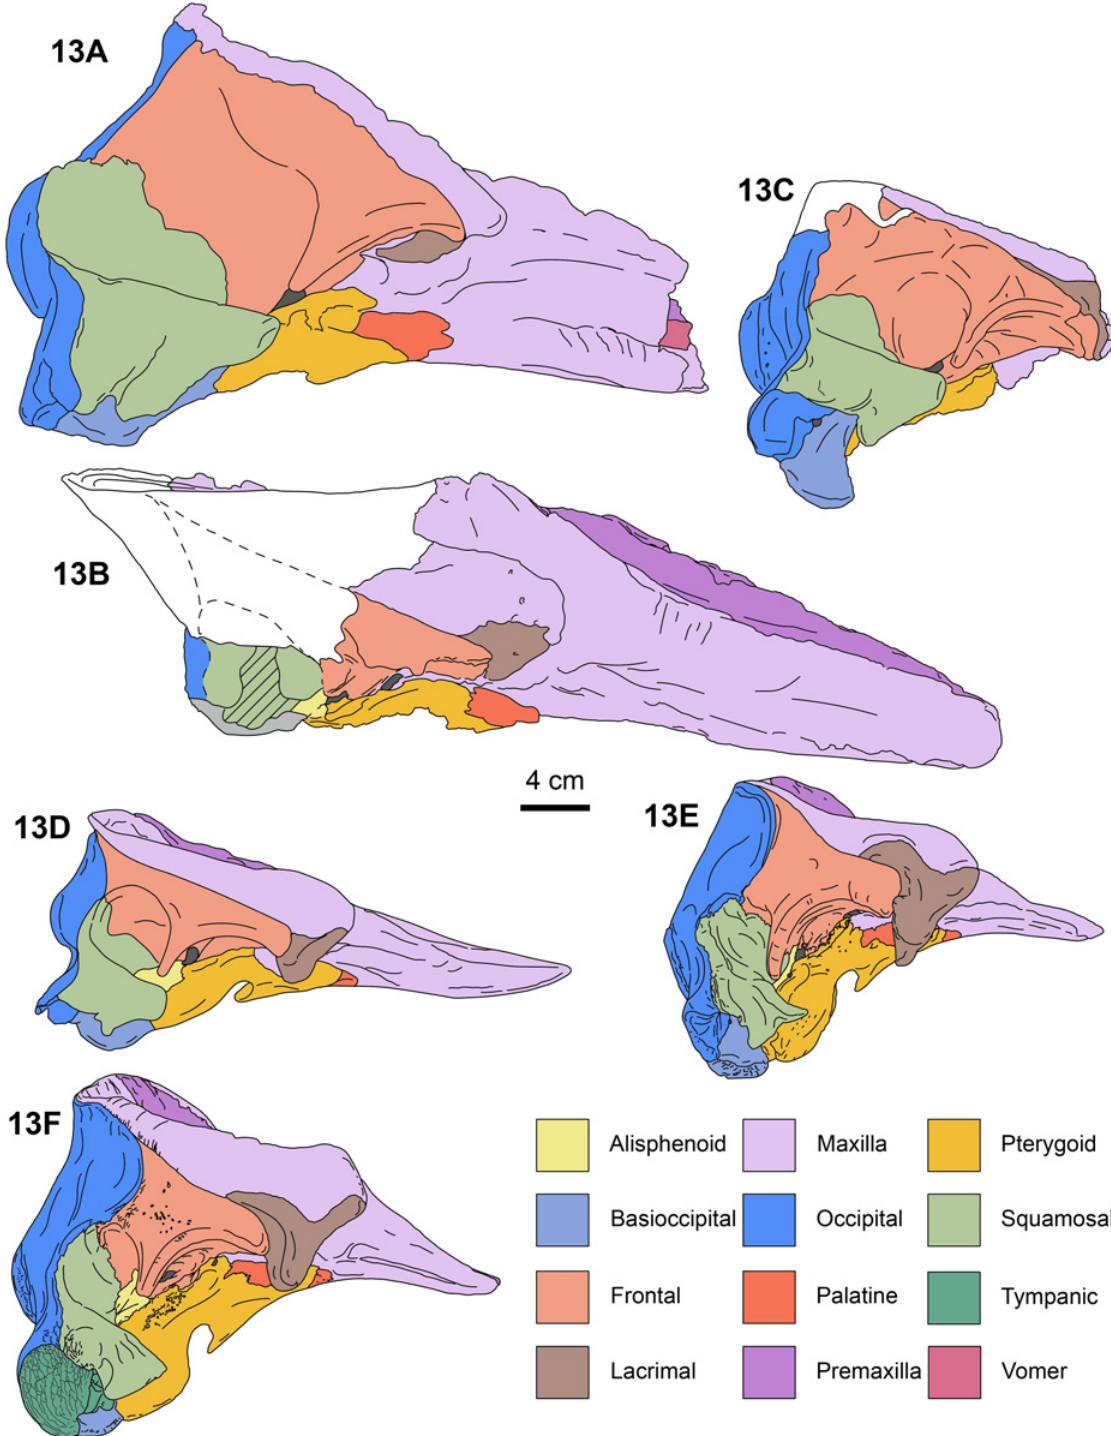
Fig 13. Right lateral views of kogiid skulls. Aprixokogia kelloggi (left side, reversed, USNM 187015), 13A, Scaphokogia cochlearis (MNHN PPI 229), 13B, Praekogia cedrosensis (UCMP 315229), 13C, Nanokogia isthmia gen. et sp. nov. (based on UF 280000 and 273554), 13D, Kogia sima (LACM 47142), 13E, and K . breviceps (LACM 95745), 13F. Each bone is color-coded for ease of comparison. Areas in white are reconstructed; diagonal lines denote broken surfaces. Illustrations based on direct observations of the specimens listed.